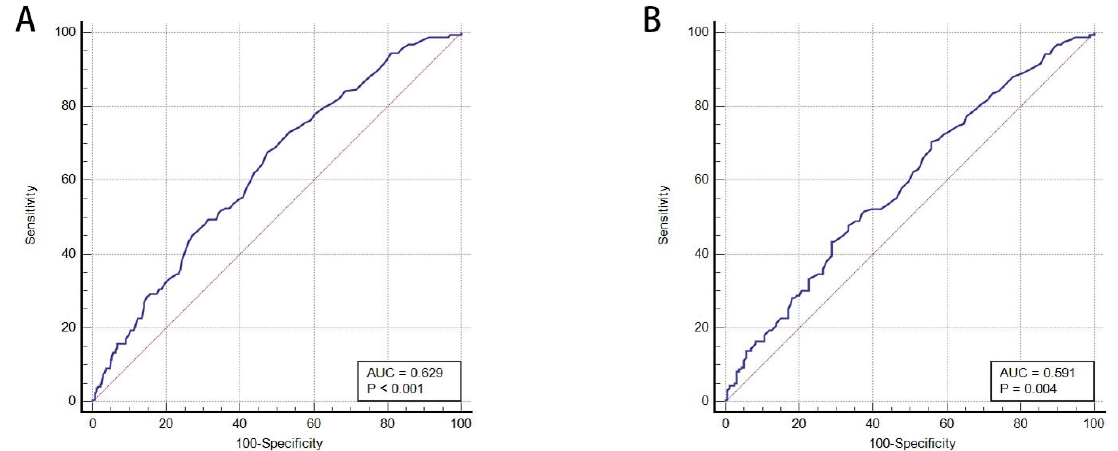
Figure 2. ( A ) Receiver operating characteristic (ROC) curve for BUN (before propensity score matching); ( B ) ROC curve for BUN (after propensity score matching). AUC, area under the curve.